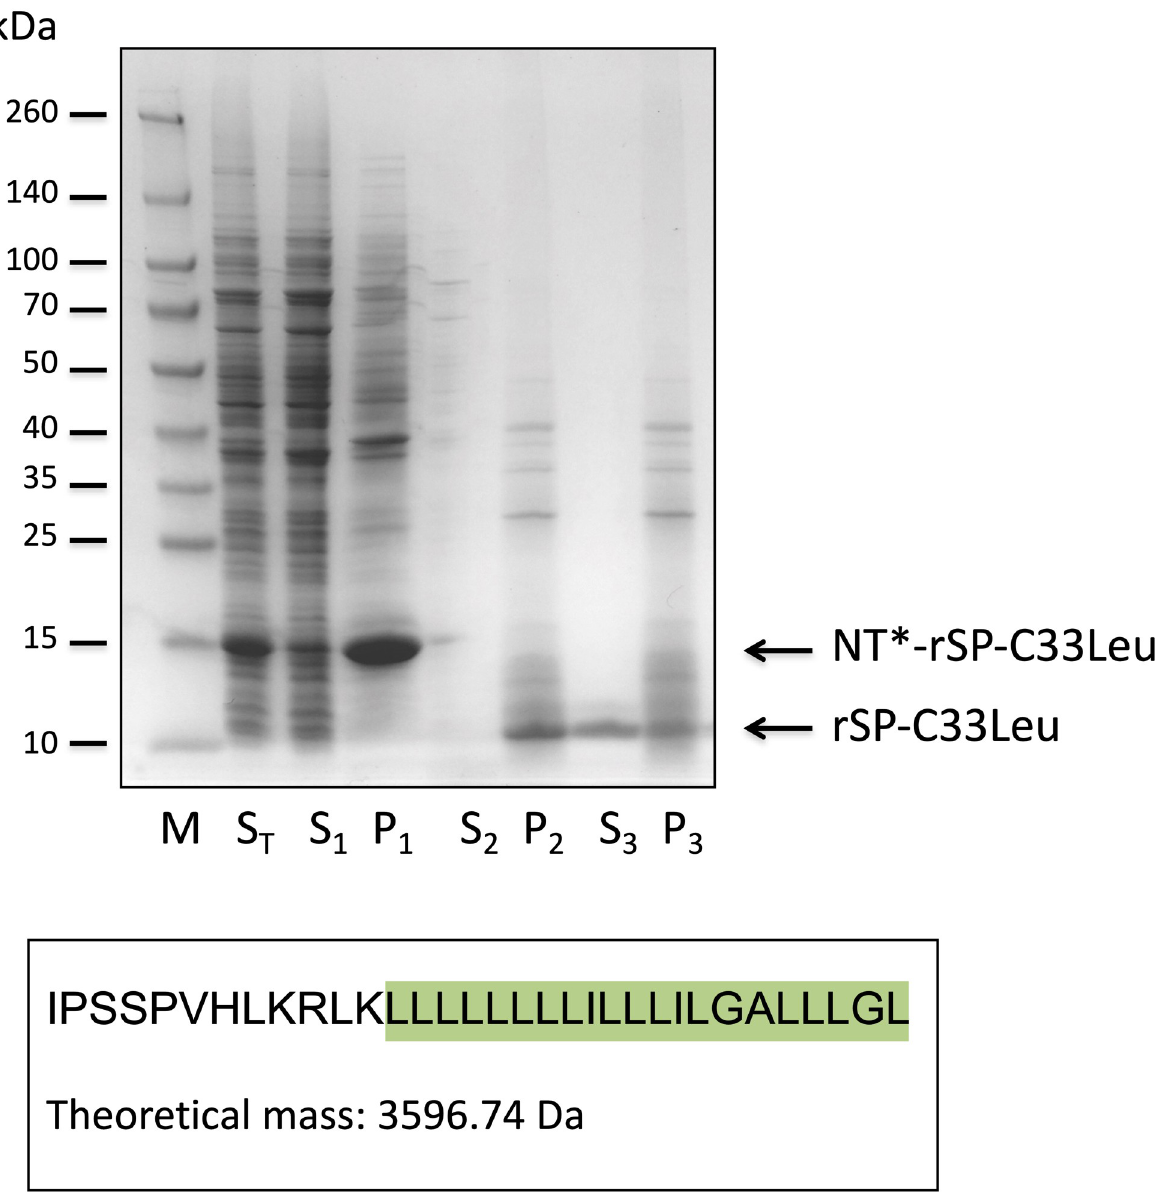
Fig 1. Non-chromatographic purification of rSP-C33Leu. SDS-PAGE indicating the different purification steps of rSP-C33Leu. The lanes show supernatant (S T ) after cell disruption, supernatant (S 1 ) and pellet (P 1 ) after NaCl precipitation, supernatant (S 2 ) and pellet (P 2 ) after CNBr cleavage and supernatant (S 3 ) and pellet (P 3 ) after resuspension in methanol:dicloroethane:H 2 O 85:10:5 (by vol). The lane labeled M shows migration of molecular size markers with identified masses i kDa. The amino acid sequence and the theoretical average molecular mass of rSP-C33Leu are shown below the SDS-PAGE, and the residues corresponding to the transmembrane region are